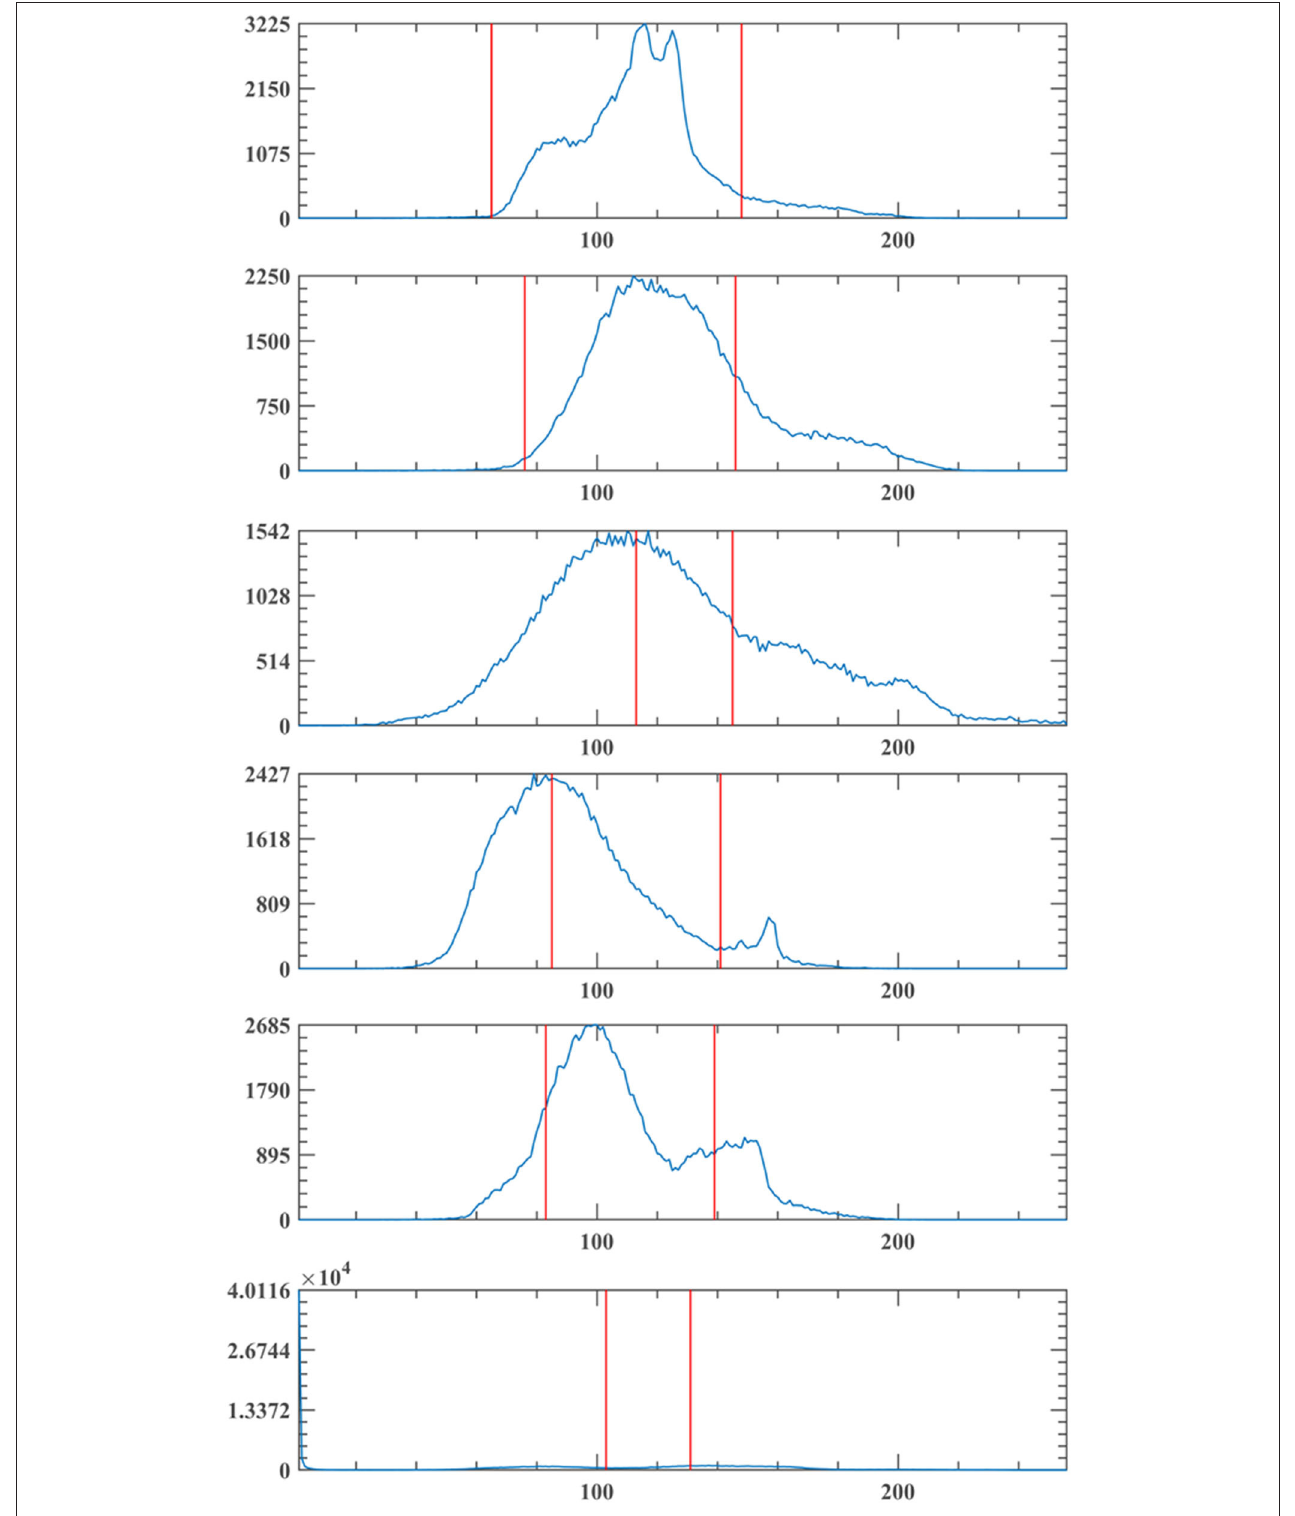
FIGURE 9 | Segmentation threshold line of GCLPSO-2D-Otsu at threshold 2.